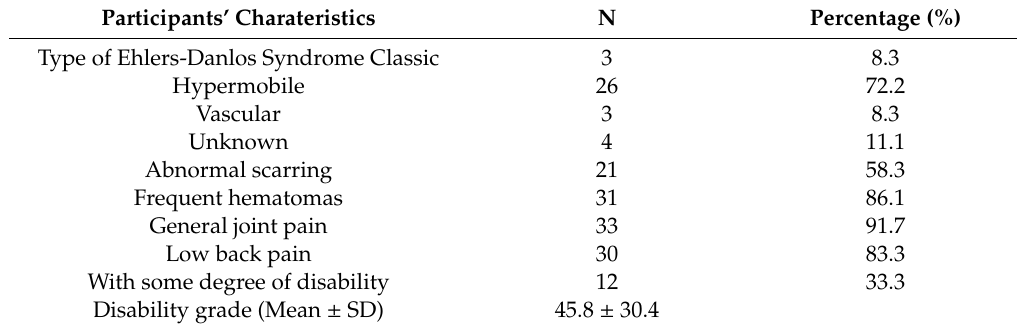
Table 2. Participants’